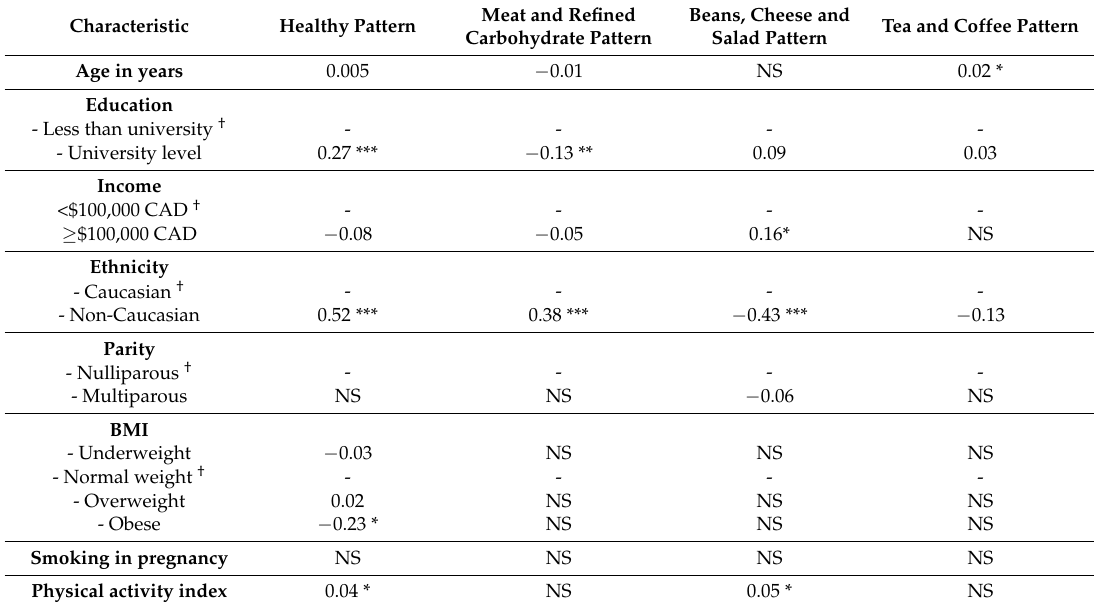
Beta coefficients (95% confidence intervals) from multivariate linear regressions of socio-demographic characteristics associated with diet pattern z